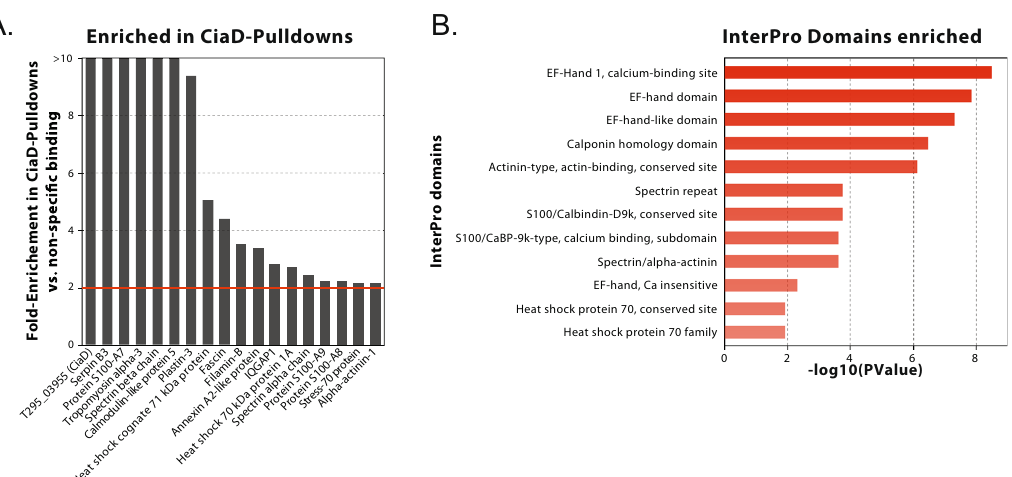
Fig. 1 Analysis of CiaD-host cell protein pull-down by LC – MS/MS indicates potential binding partners. A CiaD and 17 human proteins, including IQGAP1, were found to be at least 2-fold more abundant in the pull-down experiments compared to similar experiments performed without CiaD. B Protein domain enrichment analysis was performed using DAVID on the list of proteins that were identi fi ed by the pull-down. Enriched InterPro protein domains that are involved in calcium signaling and actin binding were identi fi ed. The x -axis indicates the p -value from a one-tailed Fisher ’ s exact